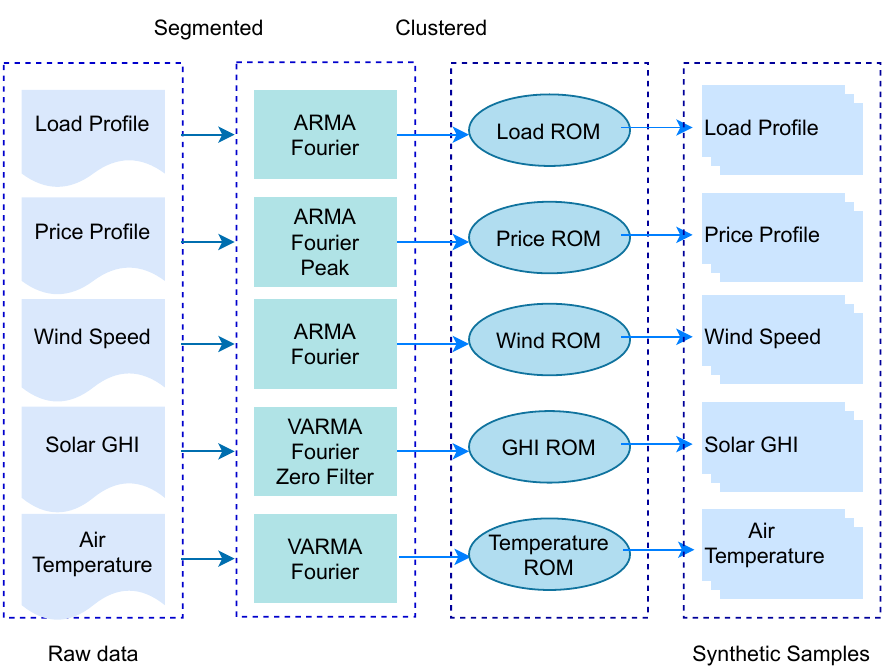
Figure 7. Synthetic time history generation